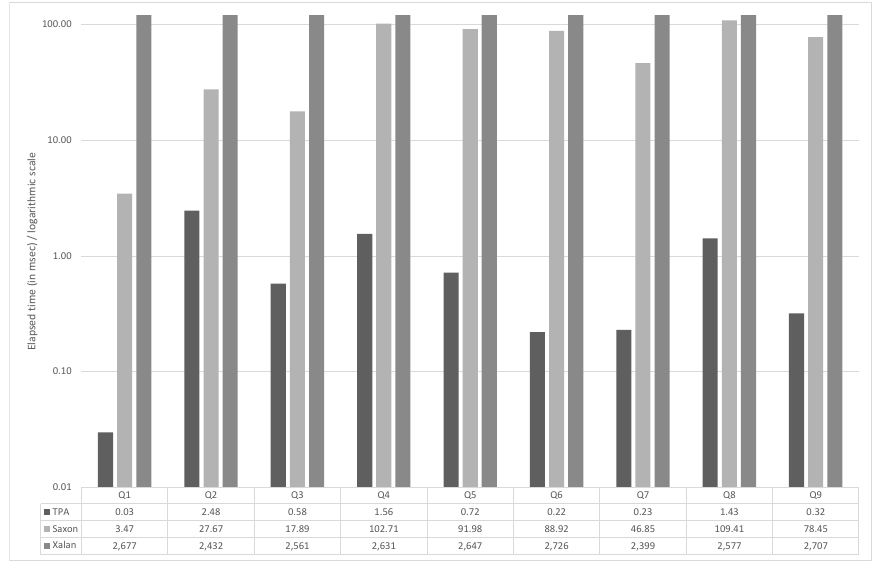
Figure 13. Performance comparison of TPA, Saxon and Xalan on XMark ( D 6 ) dataset (logarithmic